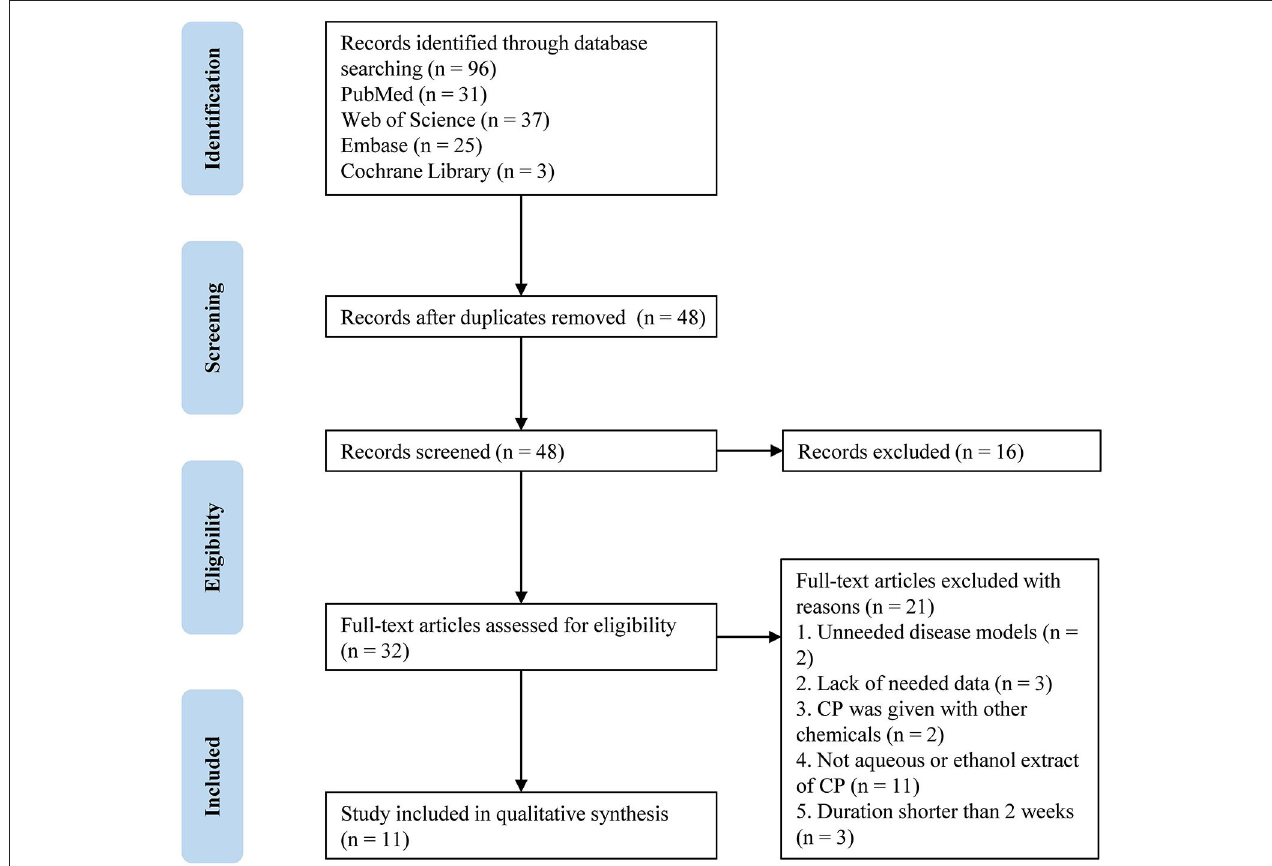
FIGURE 1 | Flow diagram for article selection for the meta-analysis. CP, Cyclocarya paliurus